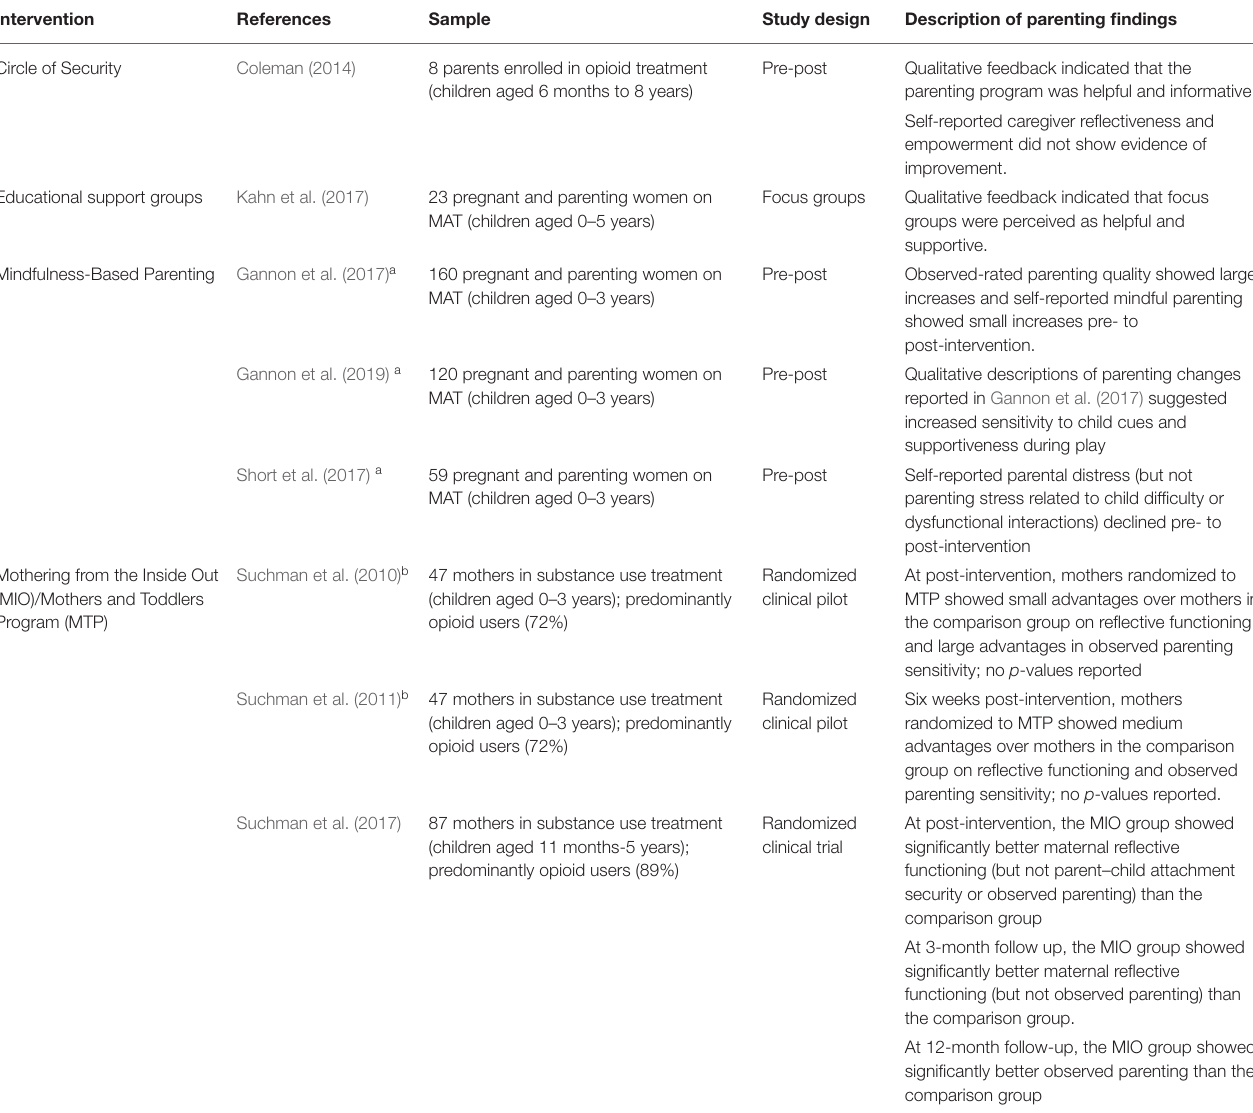
TABLE 1 | Interventions targeting parenting among opioid-dependent mothers of infants.